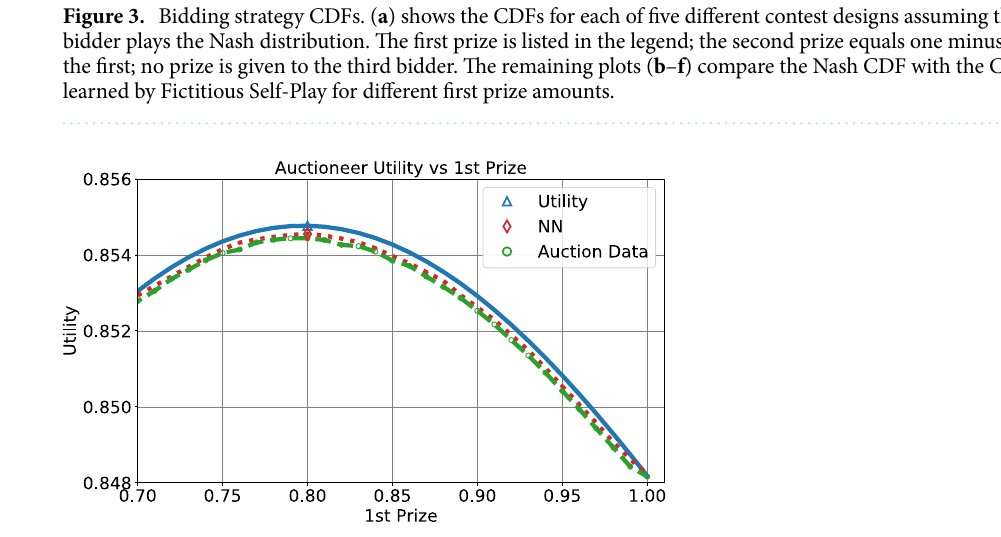
Figure 4. Auctioneer utility as a function of the first rank prize, given by the analytical Nash CDFs, the simulation data, and the trained network. Markers denote